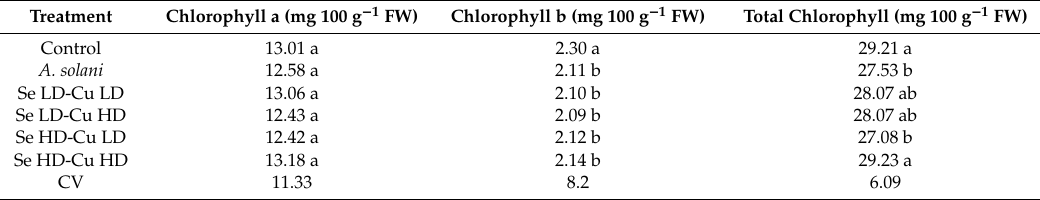
Table 2. Photosynthetic pigments in the leaves of tomato